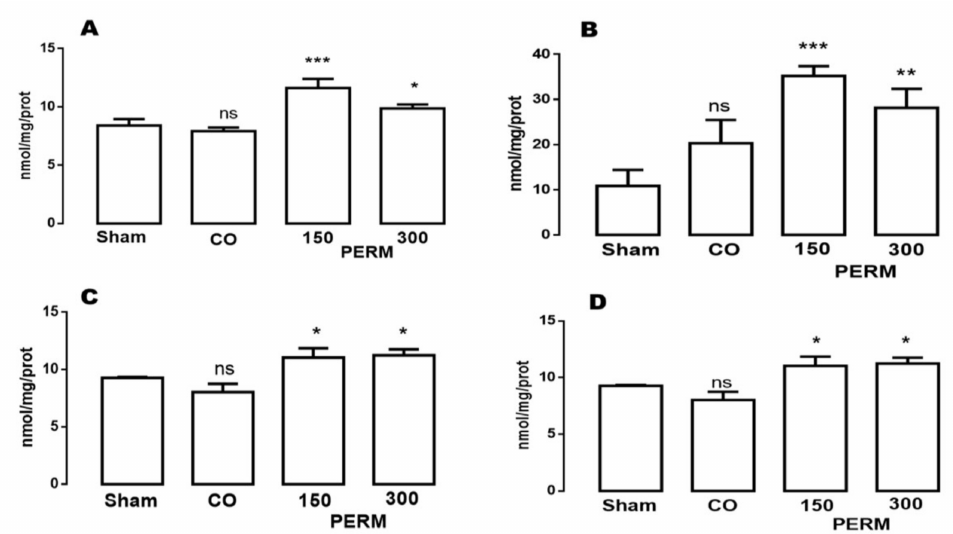
Figure 1. Effect of permethrin on protein carbonyl content in different tissues of the brain: ( A ) cerebellum; ( B ) cerebral cortex; ( C ) cerebral hemispheres; ( D ) medulla; at dose of 150 (1/10 of LD50) and 300 mg/kg body weight/day (1/5 of LD50). Corn oil (CO) was administered as vehicle (1 mL/kg/day) for 15 days. The results were analyzed by ANOVAs; Bonferroni’s multiple comparisons test was used to compare the outcomes between the experimental, vehicle and sham groups. Mean ± standard deviations ( n = 6 per group). Without statistically different is showed as ns. *** p < 0.0001 vs. sham group; ** p < 0.001 vs. sham group, * p < 0.01 vs. sham group; ns (not significant). CO: Corn oil, PERM: Permethrin.